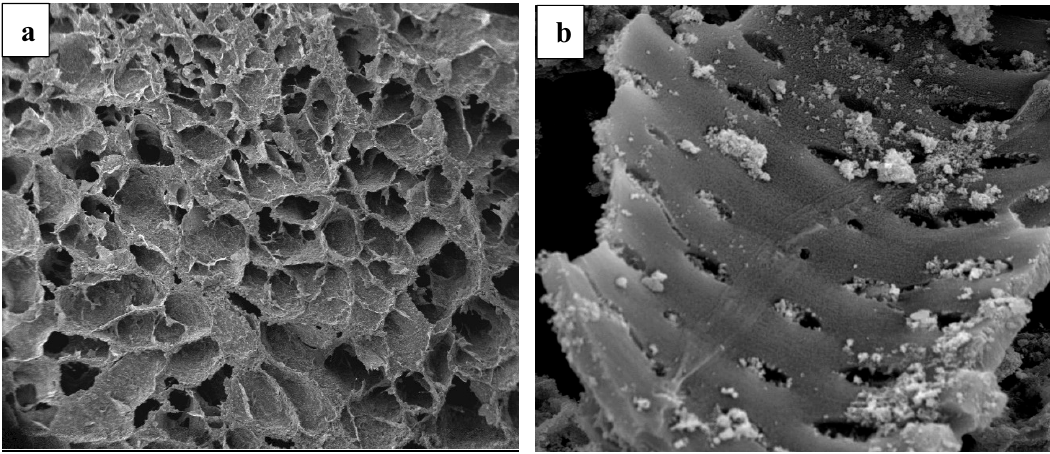
Figure 2. SEM images of ( a ) synthesised AC and ( b ) Fe 3 O 4 /AC.